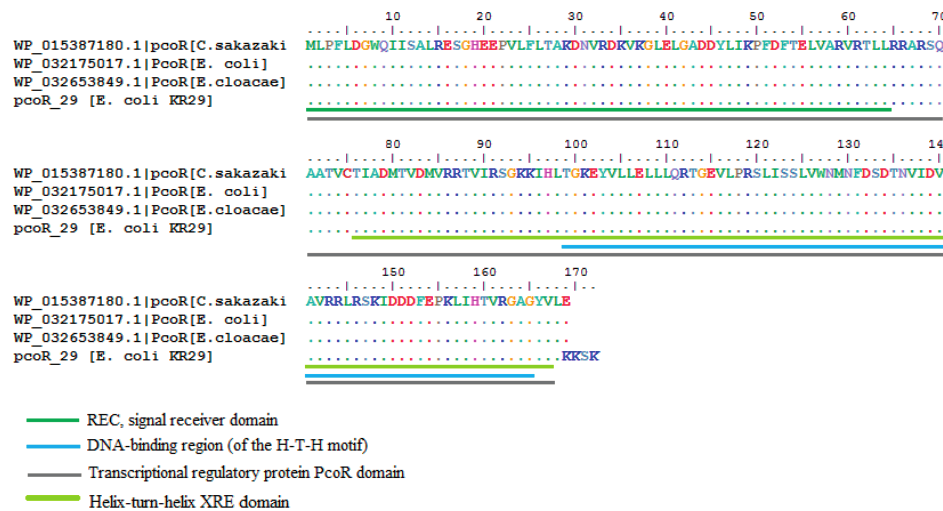
Figure 6. Alignment of the PcoR protein from Cronobacter sakazakii (WP015387180.1) with the predicted partial PcoR proteins from Lysinibacillus KR25 and E. coli KR29.